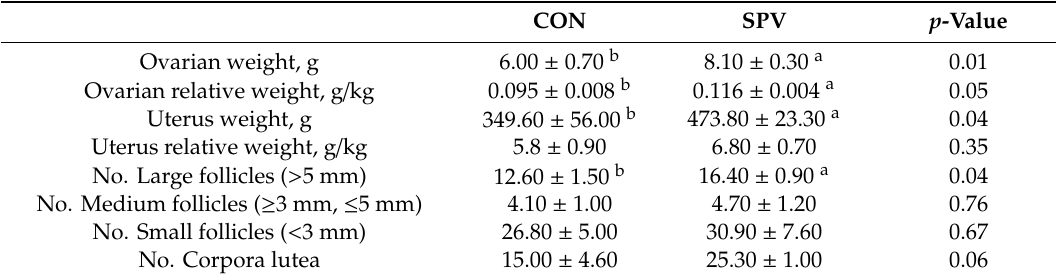
Table 5. E ff ect of sweet potato vine supplementation on the reproductive organ development and total follicle population in Meishan